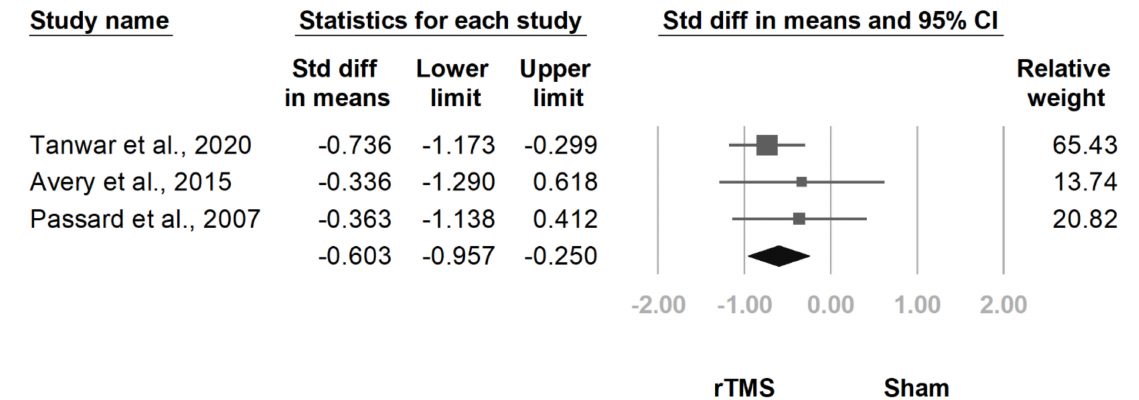
Figure 19. Forest plot of standardized mean differences in Hamilton Depression Rating Scale at follow-up at one and a half to three months after last treatment session. Squares indicate effect sizes of individual studies, lines indicate 95% CI, and diamond indicates the summarized effect